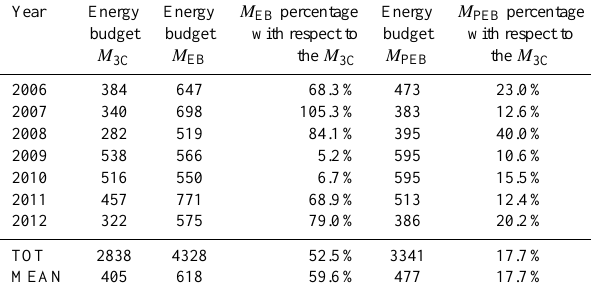
Table 1. For each year the following data are shown during snow melting period: cumulative energy budget M 3C value, cumulative energy budget neglecting albedo values ( M EB until 30 June), cu- mulative energy budget M PEB , and percentages with respect to the M 3C values. All energy amounts are in